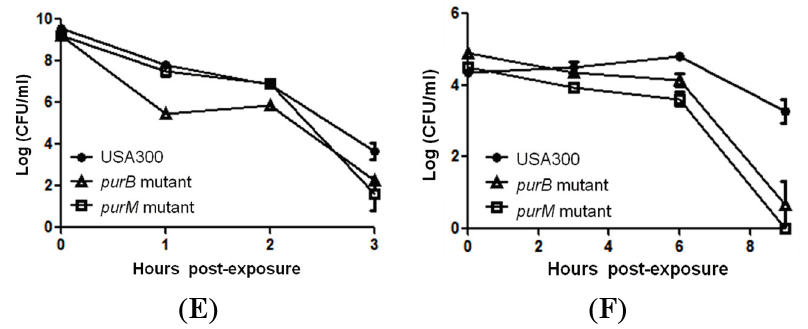
Figure 3. ( A , B ) Parental strain USA300 and pur mutants showed no defects in log phase